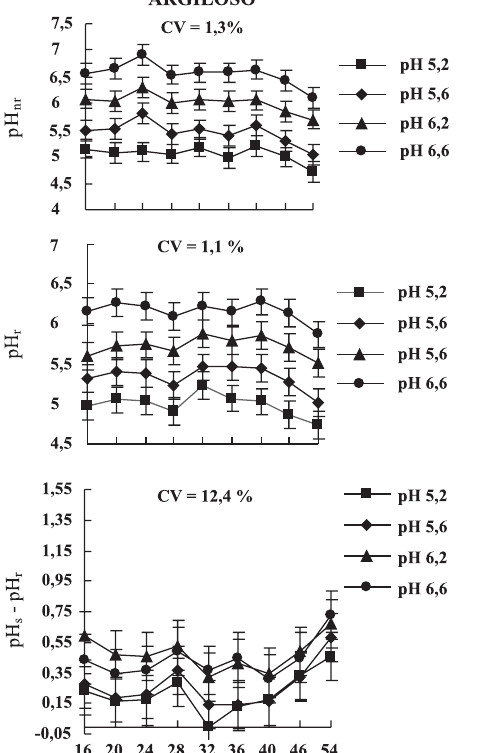
) e no poder-tampão do pH ( ΔΔΔΔΔ pH = pH nr